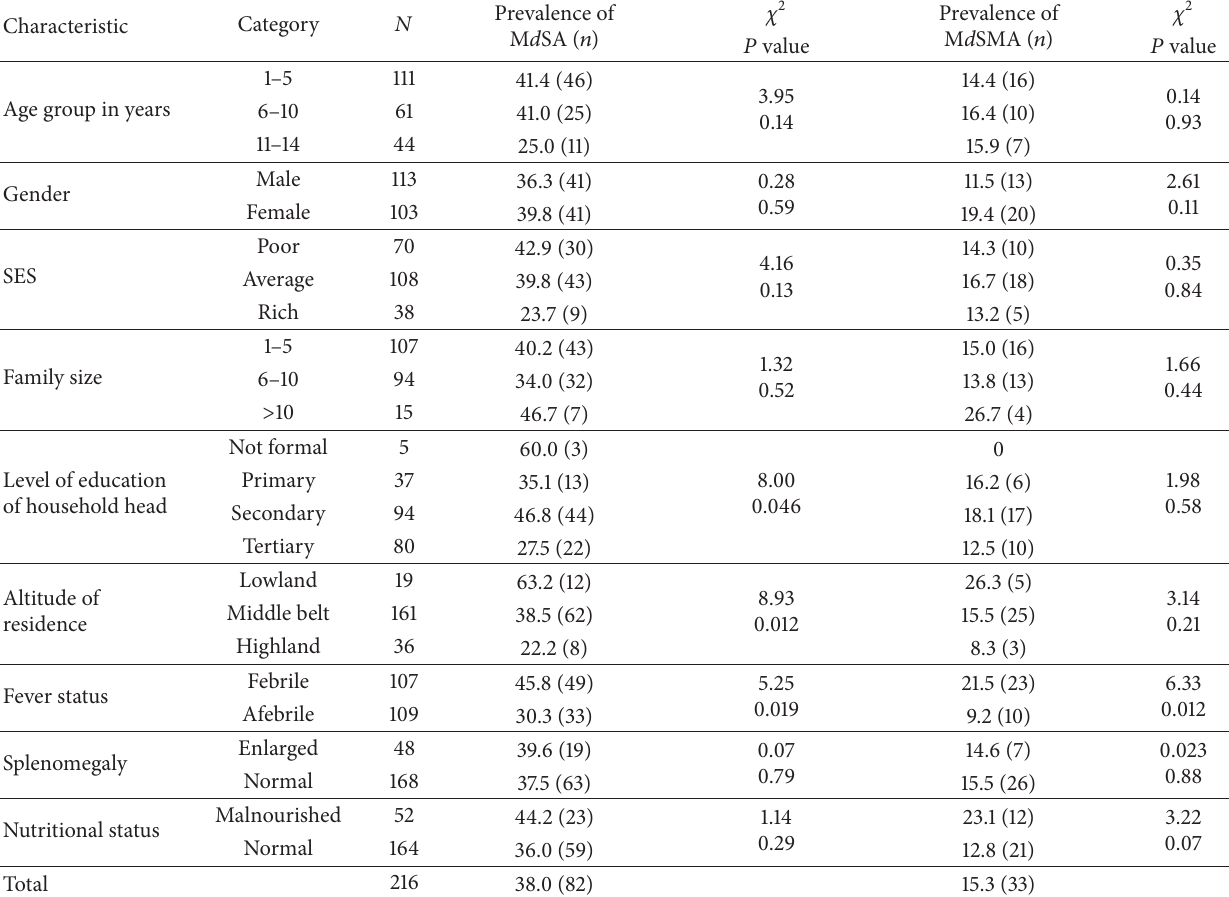
Table 2: Prevalence of M d SA and M d SMA as affected by sociodemographic and clinical factors at presentation.